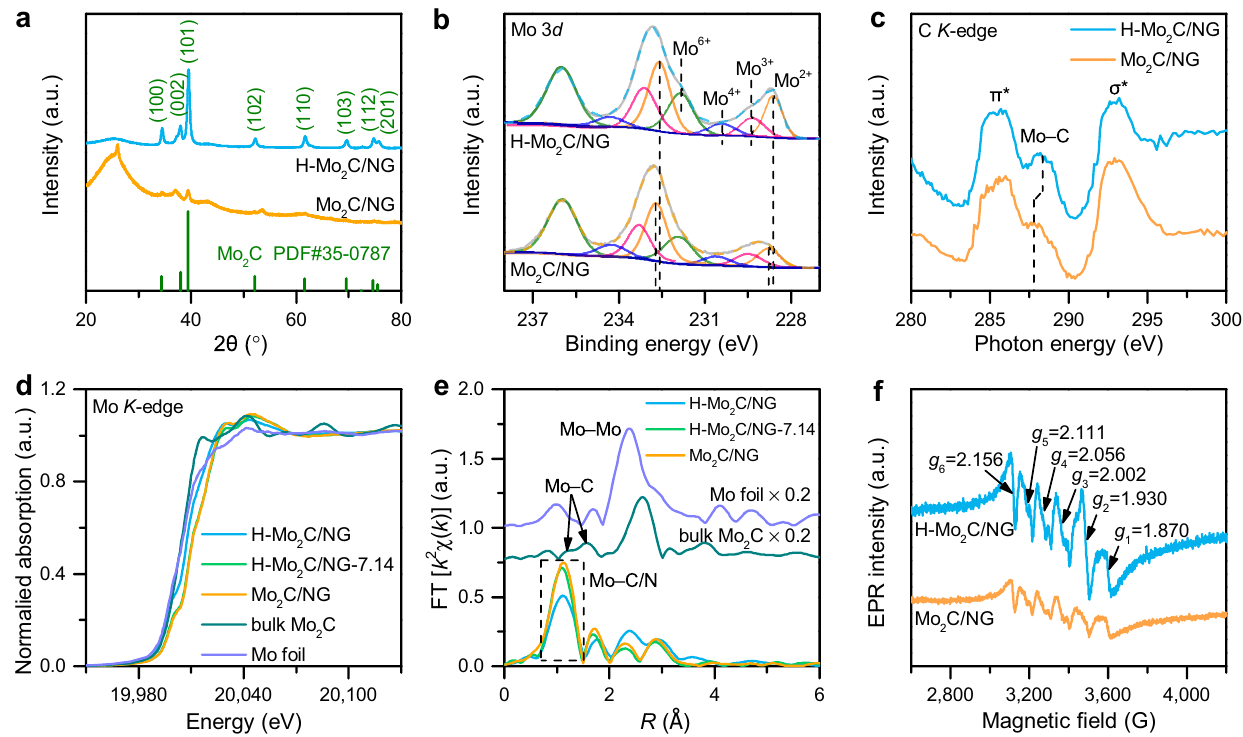
Fig. 4 | Spectroscopy characterization of Mo 2 C hybrids. a XRD patterns of H-Mo 2 C/NG and Mo 2 C/NG. The peaks near 2 θ =26° and 43° are assigned to the (002)and(100)re fl ectionsofgraphene,respectively,andtheweakpeaksat37°and 53° are considered to be the (211) and (222) planes of MoO 2 (PDF#32-0671), respectively. b The high-resolution Mo 3 d XPS spectra of H-Mo 2 C/NG and Mo 2 C/ NG.Mo 4+ andMo 6+ canbeattributedtoMoO 2 andMoO 3 causedbytheoxidationof molybdenum species in ambient atmosphere, respectively. The Mo 2+ and Mo 3+ are assigned to carbides and nitrides, respectively, which are known to serve as active sites for HER 6 . c C K -edge XANES spectra of H-Mo 2 C/NG and Mo 2 C/NG. The